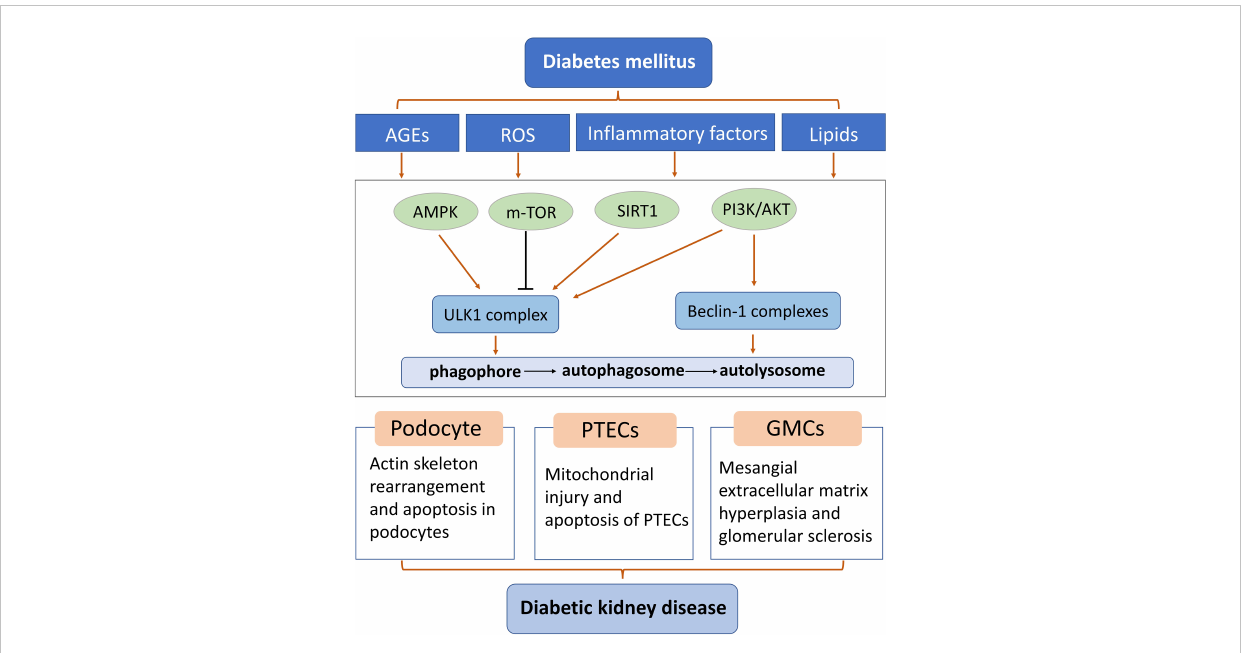
FIGURE 2 Diagram of some mechanisms of autophagy in podocytes, glomerular mesangial cells, and proximal renal tubular epithelial cells of diabetic kidney disease. AGEs: advanced glycation end products; GMCs: glomerular mesangial cells; PTEC: proximal renal tubular epithelial cells; ROS: reactive oxygen